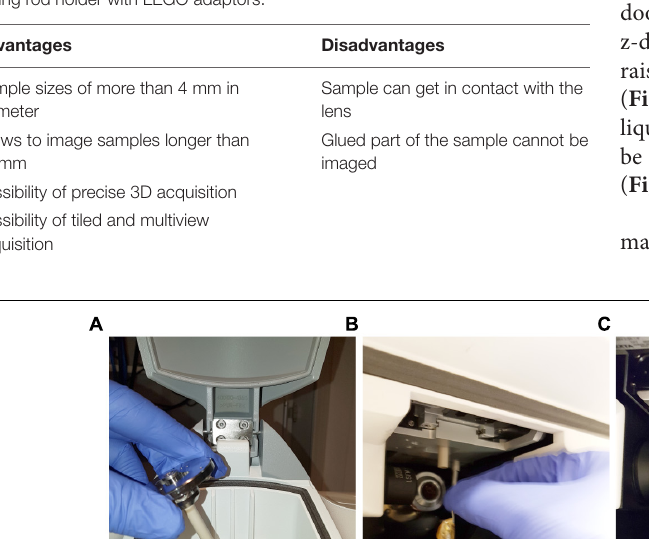
TABLE 2 | Advantages and disadvantages of the mounting strategy using the sliding rod holder with LEGO adaptors.